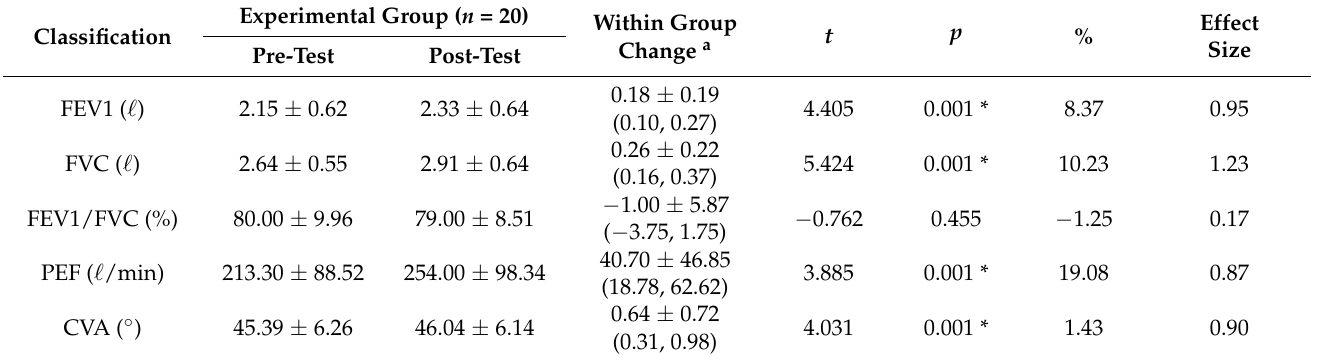
Table 2. Changes in pulmonary function, craniovertebral angle after